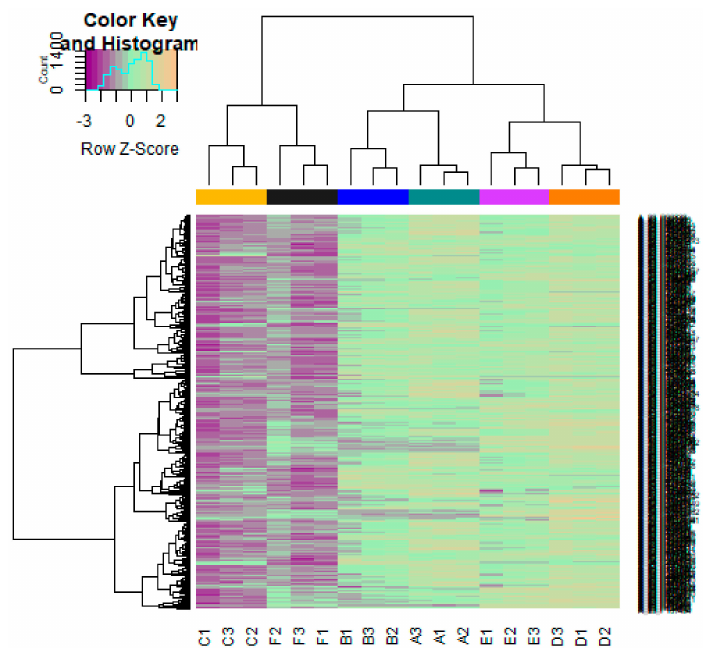
Figure 4. Heat map of up-regulated di ff erentially expressed genes. The legend on the top left indicates log fold change of genes. (A1, A2, A3 = T47D (wild type genotype + estradiol); B1, B2, B3 = T47D (wild type genotype + none); C1, C2, C3 = T47D (wild type genotype + tamoxifen); D1, D2, D3 = T47D (overexpressing Split Ends (SPEN) + estradiol); E1, E2, E3 = T47D (overexpressing Split Ends (SPEN) + none); F1, F2, F3 = T47D (overexpressing Split Ends (SPEN) + tamoxifen)).